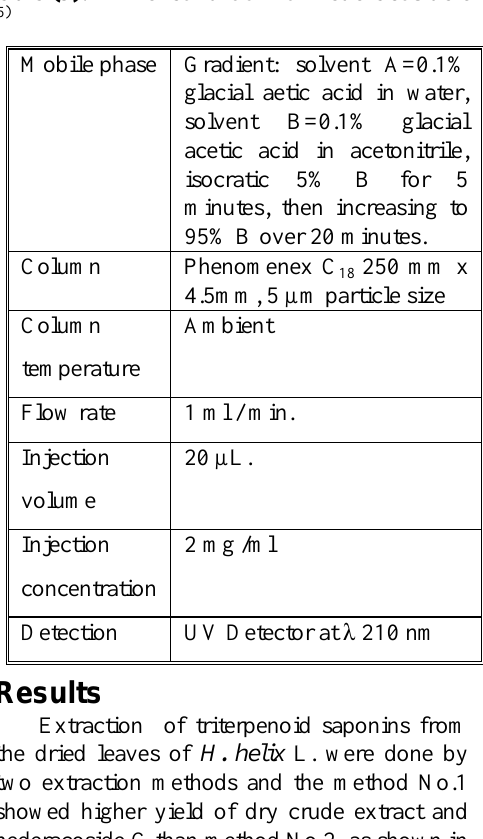
Table (3): HPLC condition for hederacoside C